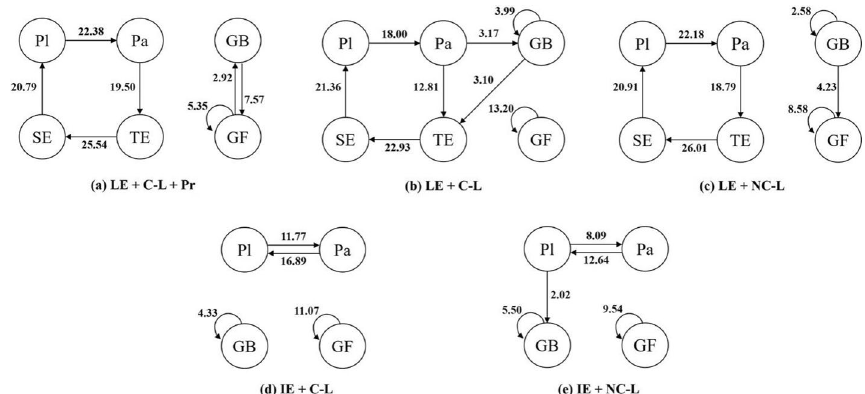
Fig. 4 Behavior transition diagrams for the ( a ) LE ( e ) IE NC-L groups. Pl + SE